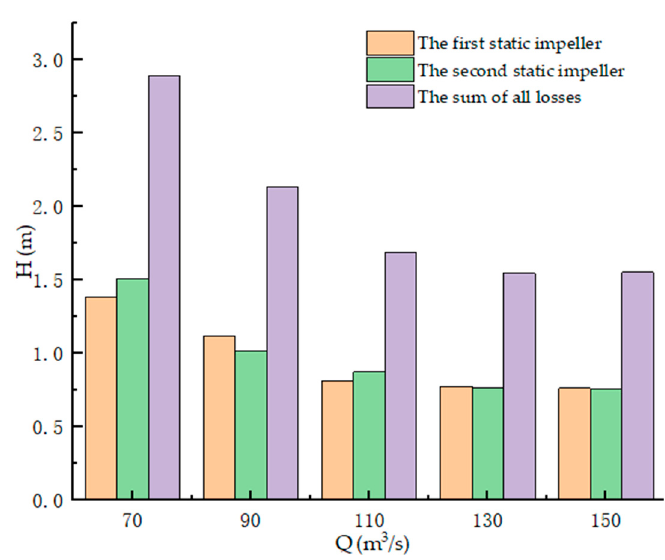
Figure 20. The energy loss of the different stages static impeller at different flow rate.